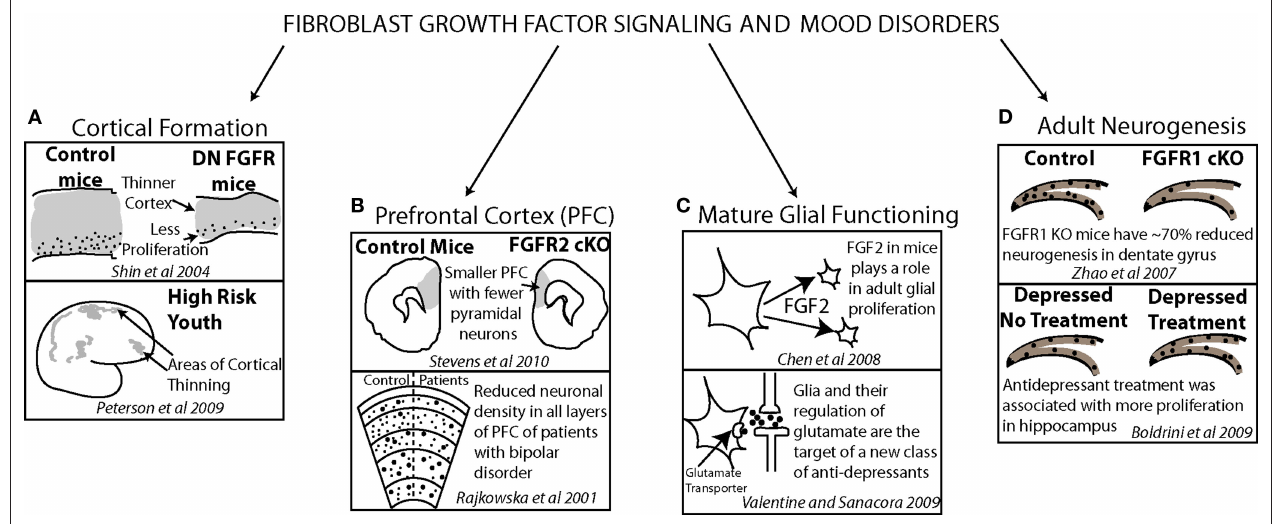
Figure 4 | evidence from model animal systems on fibroblast growth factor, cortical anatomy and functioning (top of each frame) converges with results from clinical studies, cortical anatomy and functioning (bottom of each frame) demonstrating how FgF may have a critical role in affective disorder psychopathology. FGF signaling contributes to normal cortical thickness and youth at risk for depression show early deficits in cortical thickness (A) . The density of neurons in prefrontal cortex is reduced in both mice lacking FGF receptors and patients with bipolar disorder (B) . A new target for antidepressant treatment is glial functioning in which FGF signaling plays a significant role (C) . FGF receptor 1 plays a role in dentate gyrus adult neurogenesis in mice and, in patients with depression, antidepressant treatment has been correlated with increased dentate gyrus proliferation (D)